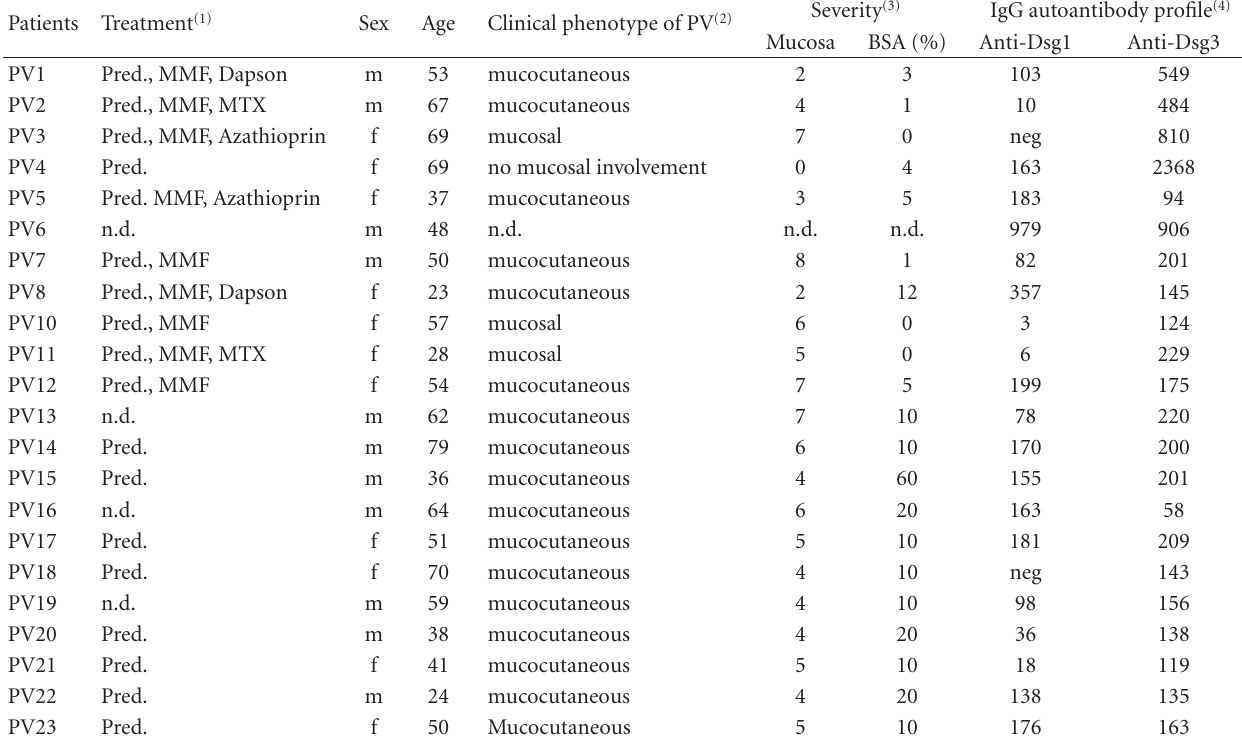
Table 1: Clinical and immunological characteristics of the pemphigus vulgaris (PV) patients on adjuvant treatment with rituximab. Patients Treatment